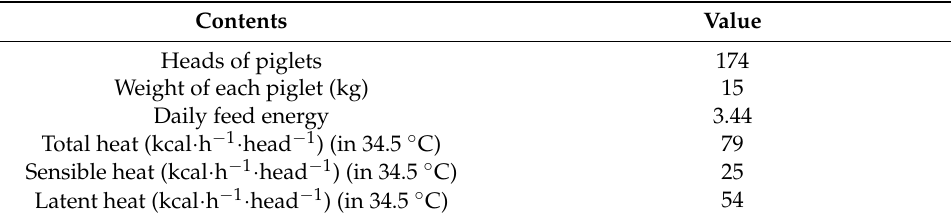
Table 1. Heat production of the piglets inside the experimental piglet room